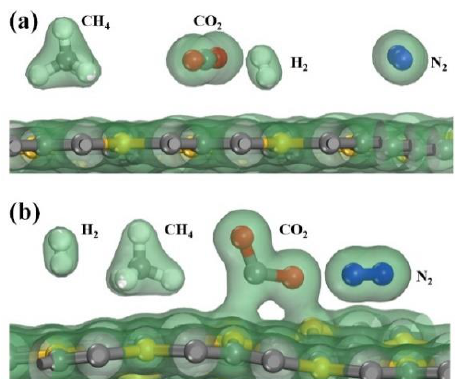
Figure 8. Top and side views of the charge density distribution of the SiC 3 nanosheet with gases molecules (i.e., CO 2 , H 2 , N 2 and CH 4 ) co-adsorption ( a ) without the injection of negative charges, and ( b ) with the injection of negative charges (1.23 × 10 14 e − /cm 2 ).